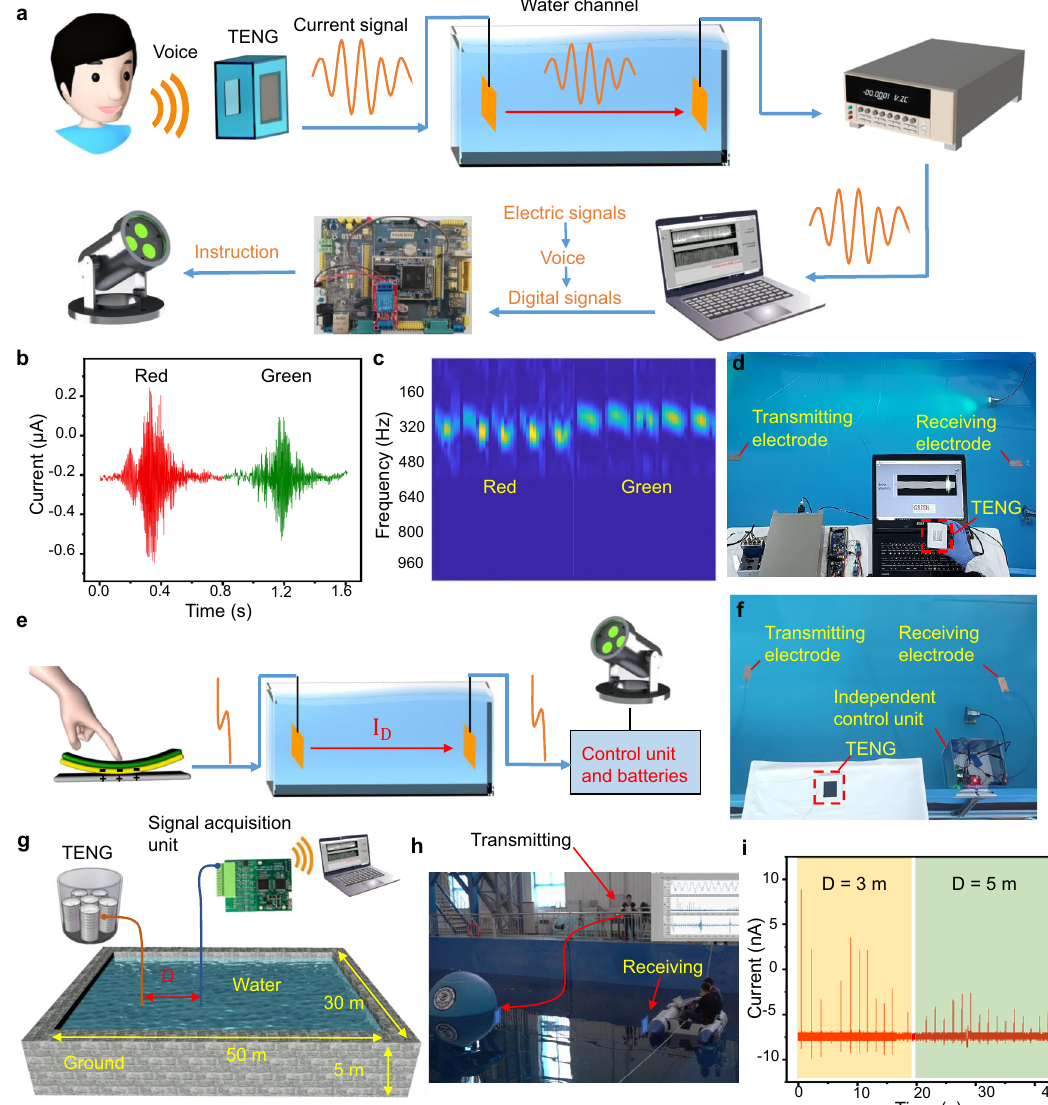
Fig. 6 Self-powered communication based on the TENGs for underwater wirelessly controlled system. a The schematic diagram of underwater light wirelessly controlled by voice. b The received signals of “ red ” and “ green ” . c The short-time Fourier transform of “ red ” and “ green ” . Colors represent amplitudes. d The photo of the voice control experiment setup. e The experiment of the button-type TENG controlling an independent system. f The photo of the touch control experiment. g The schematic diagram and ( h ) The photo of the experiment in a 50 m × 30 m × 5 m basin. D is the distance between two electrodes. i The received current signals